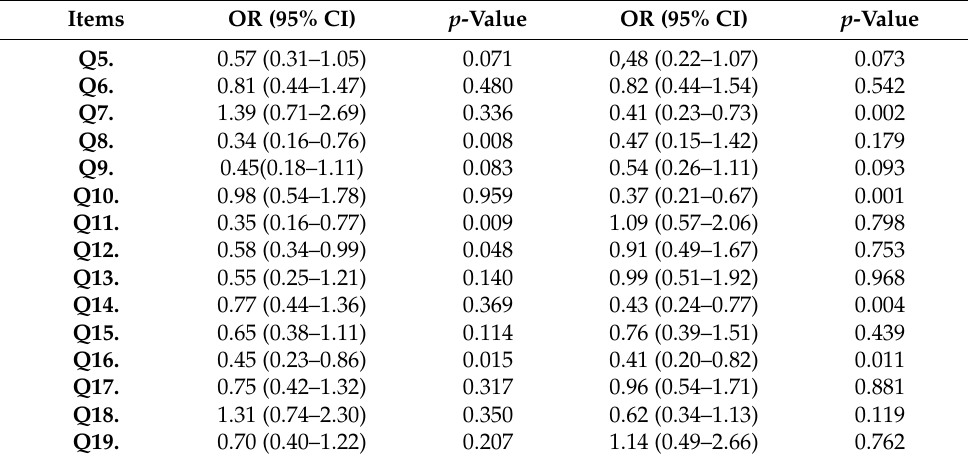
Table 5. Comparison of knowledge scores after educational intervention between G1 and G2; G3 and